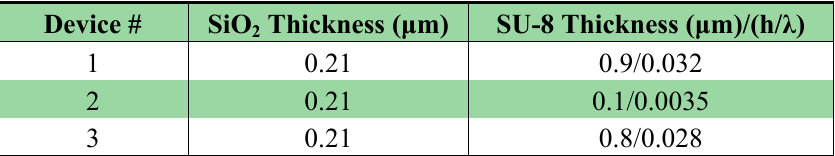
Table 3. Design parameters of the fabricated